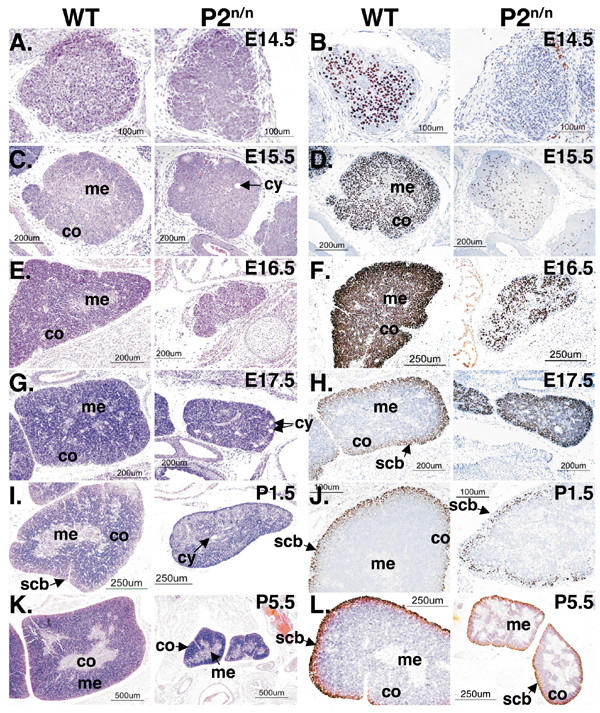
Histological and IHC analysis of thymus development in WT and P2neo/neo mice. (A, C, E, G, I, K) Transverse sections of WT (left panels) and P2neo/neo (right panels) thymic lobes stained with hematoxylin and eosin (HE). co = cortex, me = medulla, scb = sub-cortical band, cy = cyst. (B, D, F, H, J, L) Immunostaining of Runx1 in sections of WT (left panels) and P2neo/neo (right panels) thymic lobes. Runx1 is detected in thymocytes, but not in thymic epithelium. A reduced number of Runx1 expressing thymocytes (that are abnormally distributed) is seen in P2neo/neo thymic lobes.